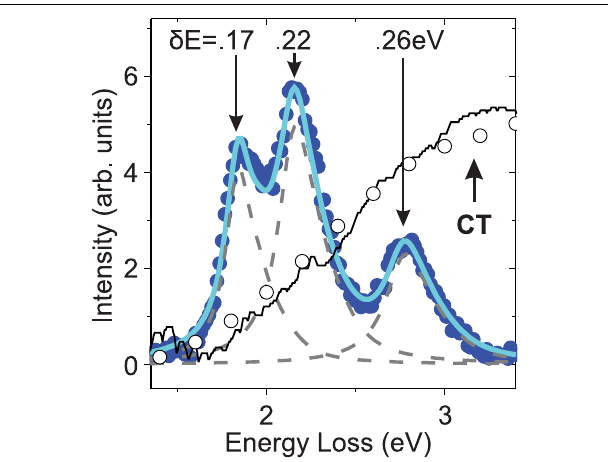
FIGURE 2 | Interacting charge transfer and orbiton modes. The orbital excitations of SrCuO 2 measured with M 3 photons (h ν = 75eV) are fitted by convoluting the intrinsic line shape of excitations in the SrCuO 2 spin chain [ 9] with the inverse lifetimes ( δ E) indicated. Dipole induced charge transfer excitations measured from (open circles) K-edge RIXS and (black line) optical ellipsometry from Popovic et al. [ 44] are overlaid, revealing delocalized charge excitations that orbitons can decay